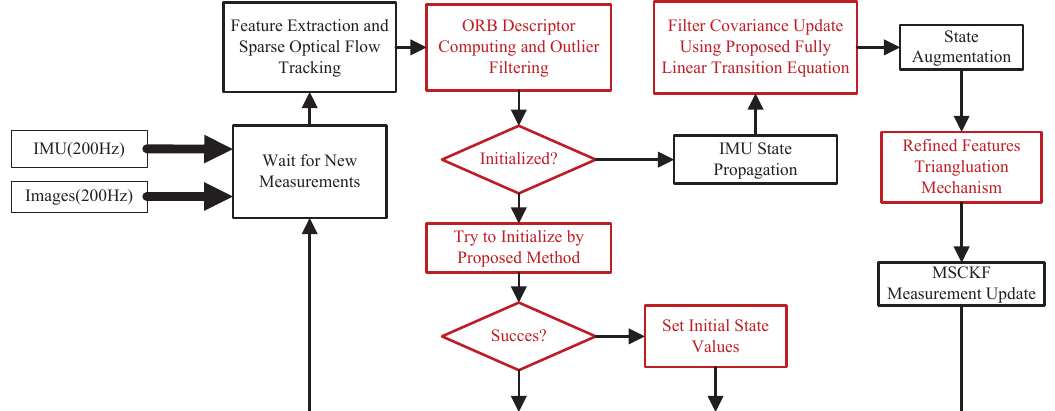
Figure 4. Flow chart of extended Kalman filter (EKF)-based visual-inertial odometry (VIO) implementation. Red sections highlight novelties proposed in this paper. Term “IMU” stands for inertial measurement unit, and term “MSCKF” stands for multi-state constraint Kalman